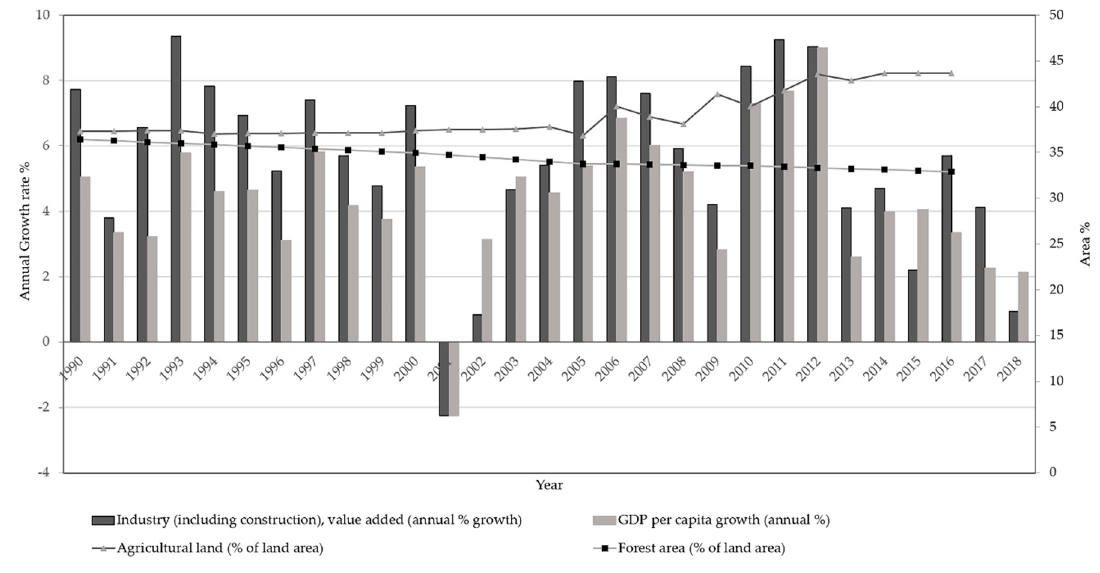
Figure 10. Annual growth rates of GNP (gross national production) per capita and value-added industry (including construction) in Sri Lanka from 1990 to 2018, area used for agricultural purposes and forested lands. Gross domestic production (GDP) annual growth [21]. Source: The World Bank, national account